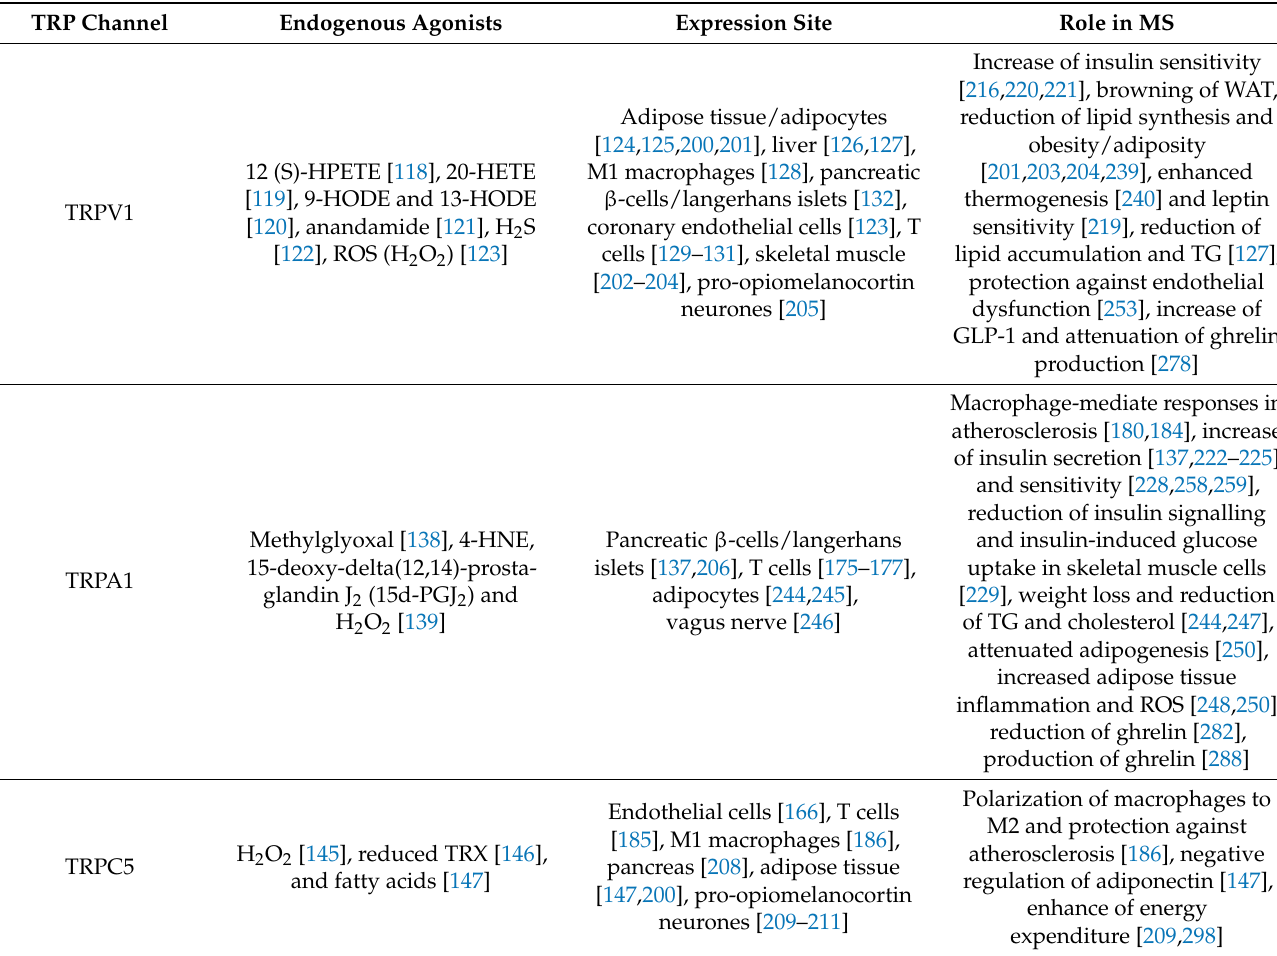
Table 3. Overall contribution of TRPV1, TRPA1 and TRPC5 to metabolic syndrome: a summary of endogenous agonists, expression sites and